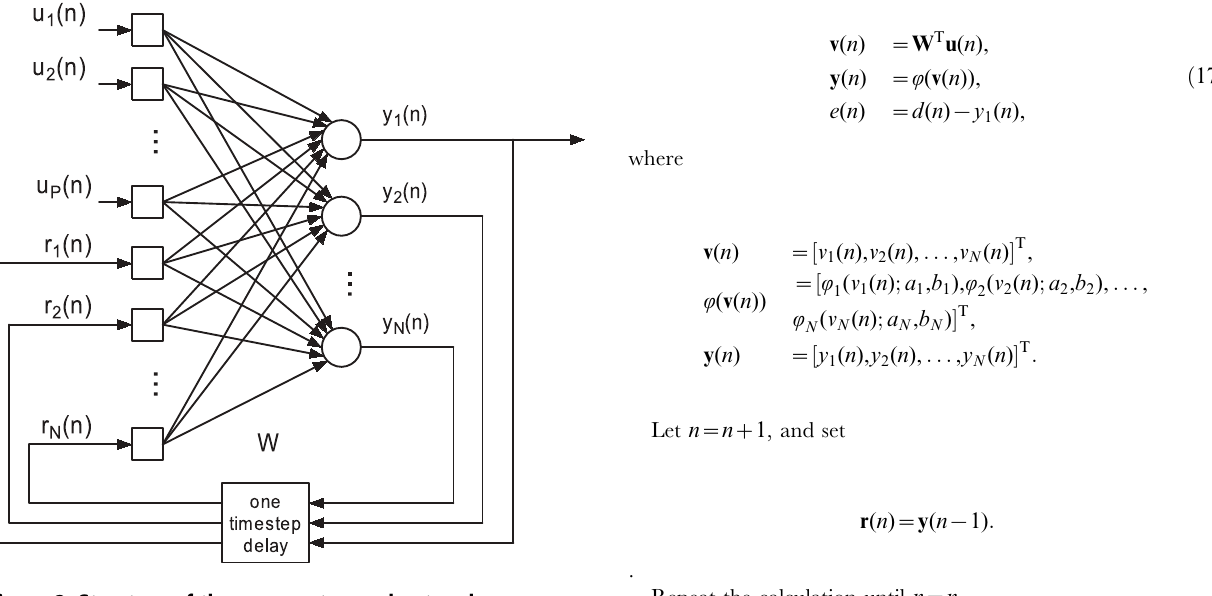
Figure 2. Structure of the recurrent neural networks.